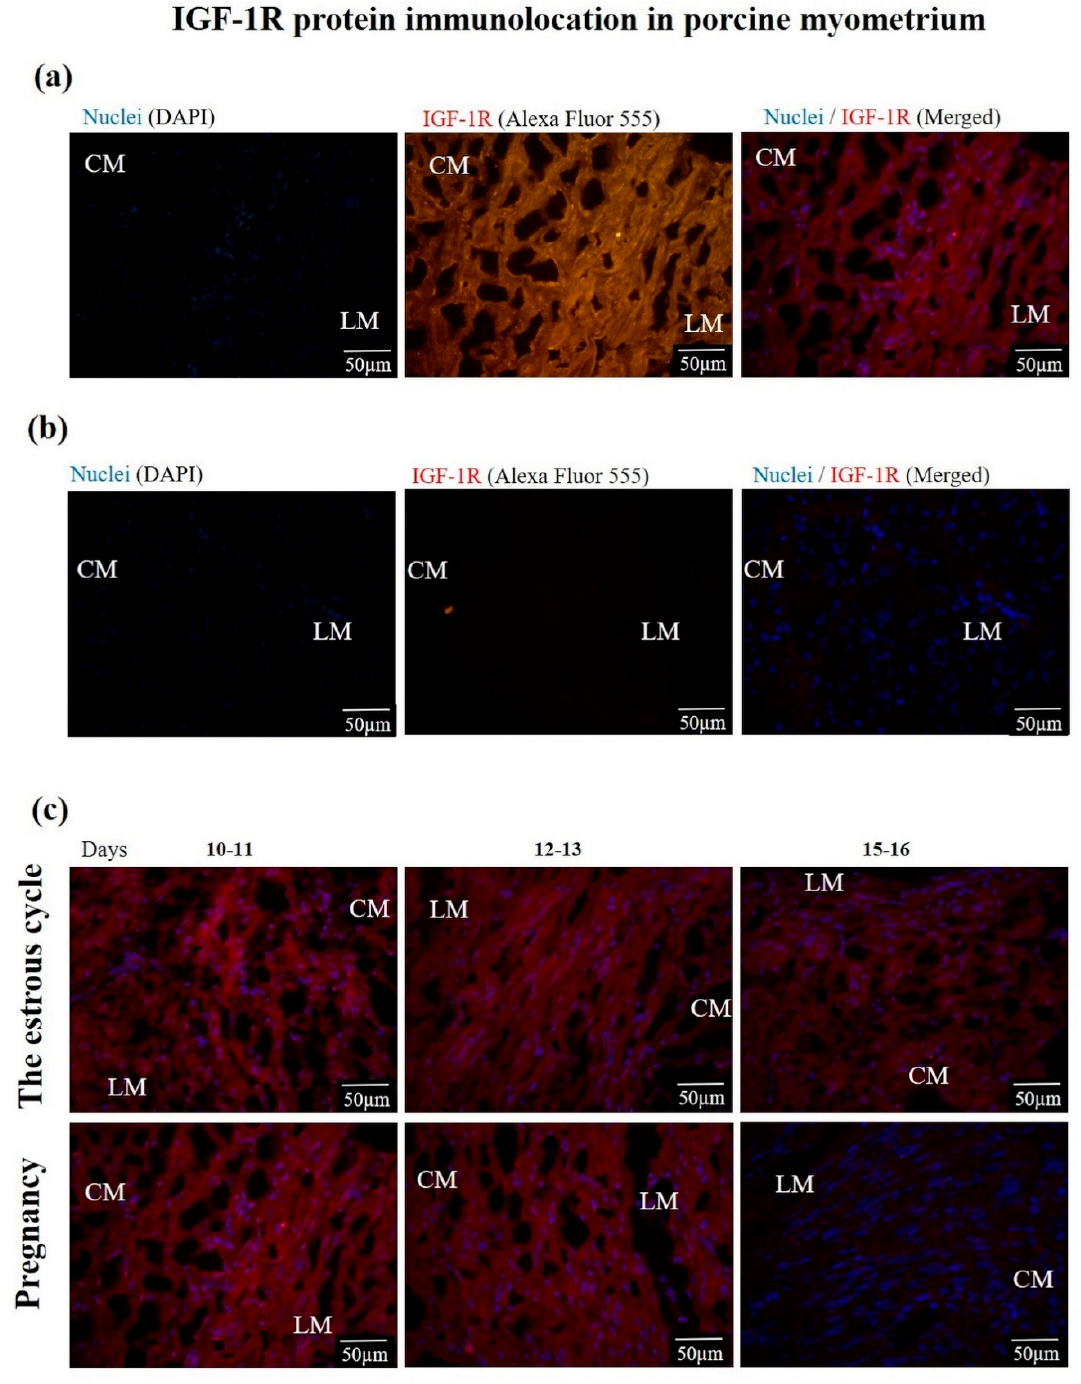
Figure 3. The representative photographs showing ( a ) IGF-1R immunostaining, ( b ) negative control, and ( c ) the myometrial location of IGF-1R during days 10–11, 12–13 and 15–16 of the estrous cycle and days 10–11, 12–13 and 15–16 of pregnancy. Magnification 400 × . CM—circular muscle; LM—longitudinal muscle. The nuclei are stained with DAPI ( blue ) and IGF-1R sites are stained with Alexa Fluor 555 ( red ).